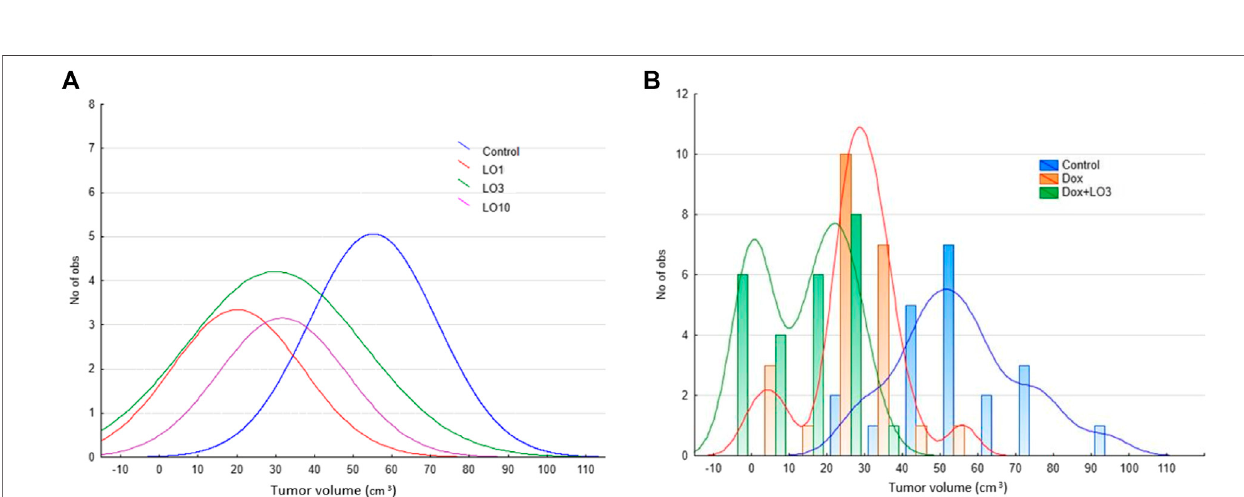
Frontiers in Pharmacology |